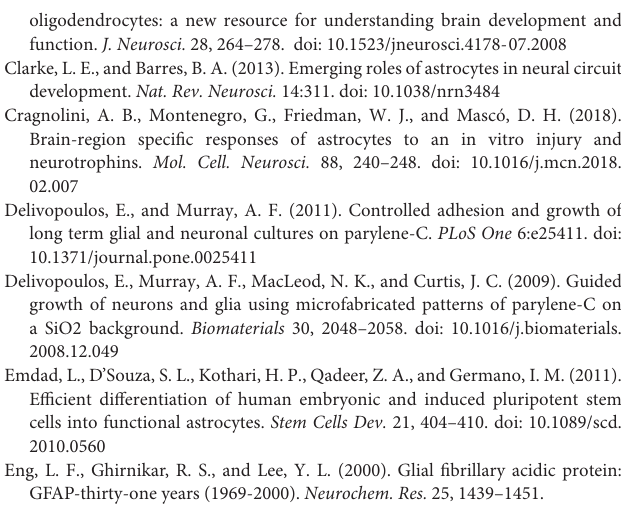
FIGURE S1 | (A) Nanog expression levels relative to GAPDH reveal statistically significant downregulation of the gene by DIV 28. (B) Representative culture example at DIV 7 with double immunofluorescent staining with astrocytic marker GFAP (green) and neuronal precursor marker Nestin (red). Under our astrocyte induction protocol, no Nestin was present at DIV 7 or later, indicating the absence of neurons and their precursors. Scale bar 20 µ m. ∗ P <